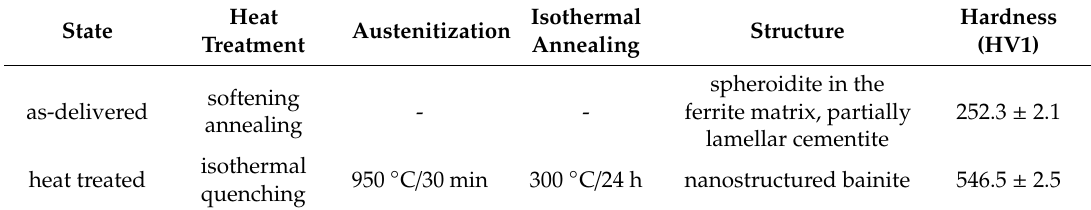
Table 2. Heat treatment parameters of 55Si7 before the welding process.